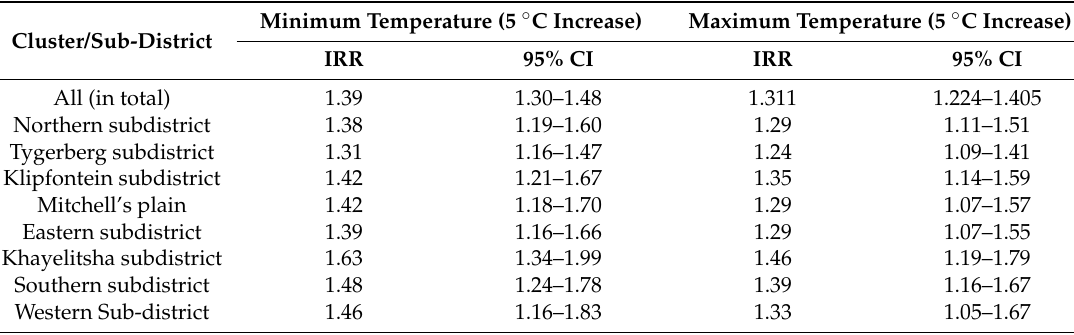
Table 3. Effect of 5 ◦ C increase in minimum and maximum